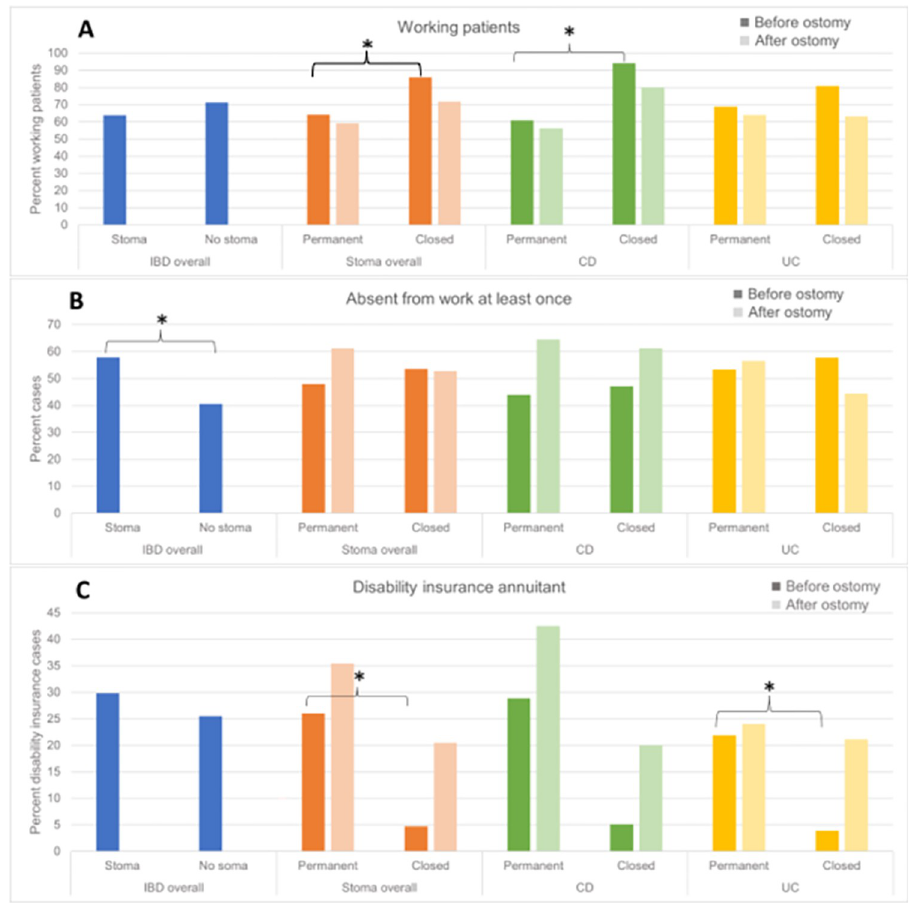
Fig 4. Working capacity and invalidity pension related data in different groups. A) Working patients in different patient groups. B) Number of patients in different groups absent from work at least once during participation in the Swiss Inflammatory Bowel Disease Cohort Study. C) Patients in different groups with disability